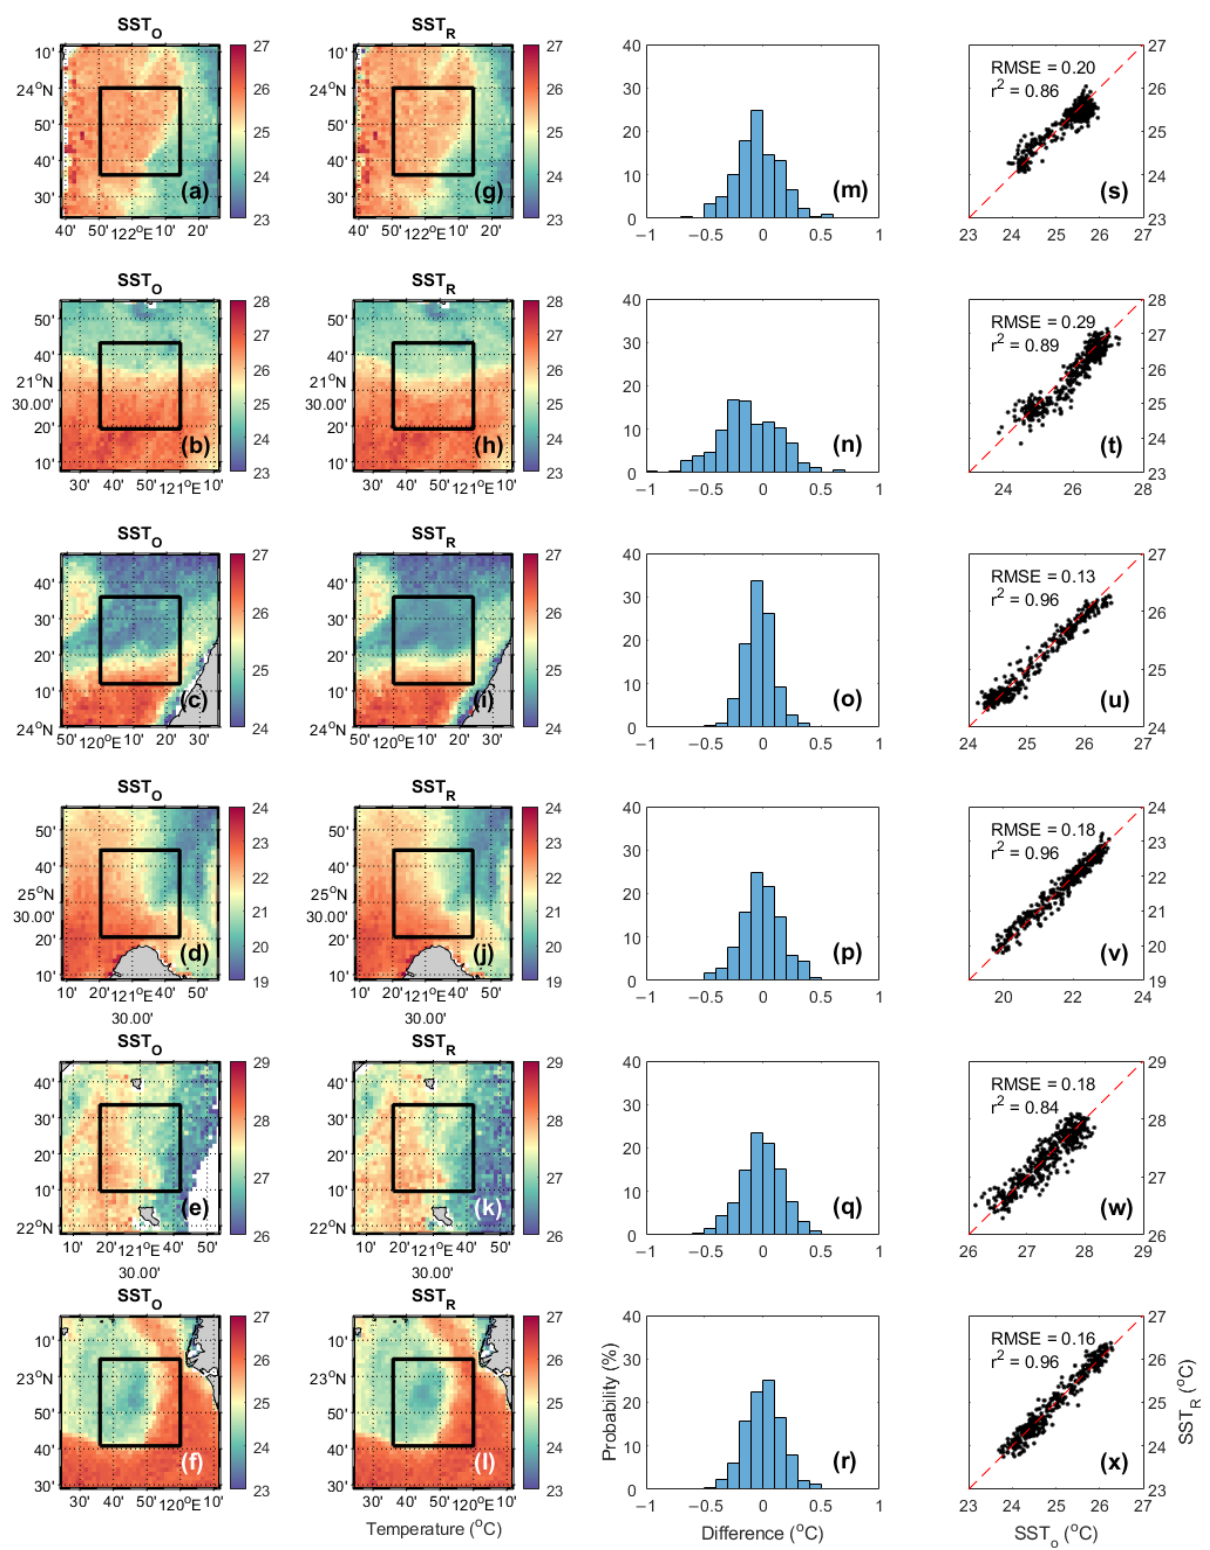
Figure 6. The best results of DINEOF SST R in the six study areas and the areas from top to bottom are east, south, west, north, southeast, and southwest. ( a – f ) SST O images. ( g – l ) SST R images using the DINEOF method. ( m – r ) Histograms of the difference between the SST O data and the SST R data. ( s – x ) Scatter plots of the SST O data and the SST R data.